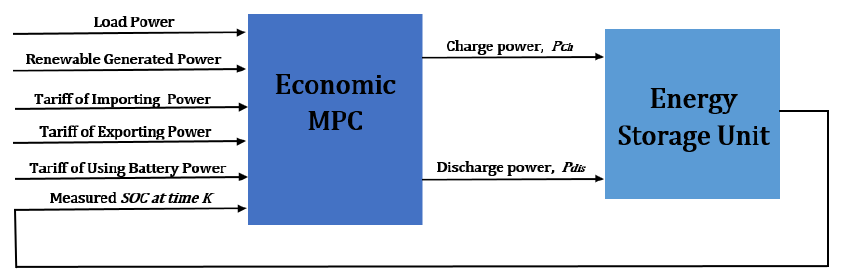
Figure 9. Economic module predictive Control .